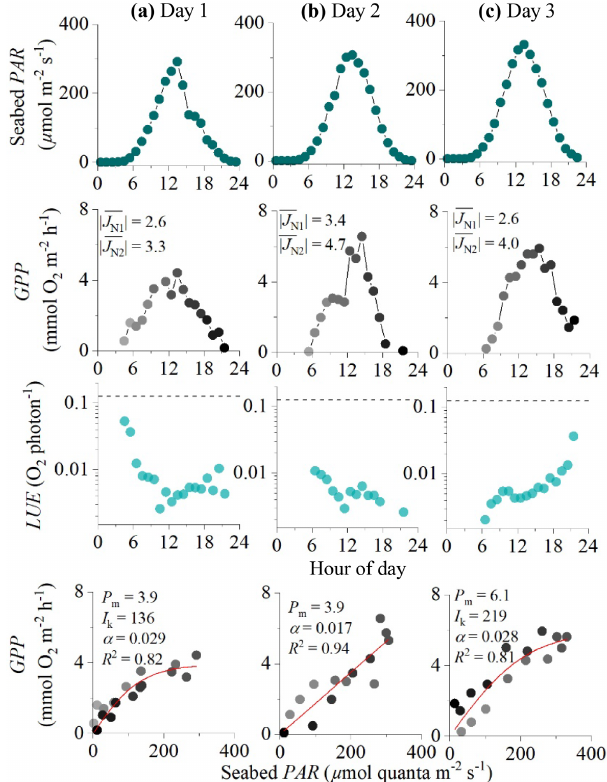
Figure 5. Eddy covariance data measured over 3 consecutive days in the rocky mussel reef in the Baltic Sea showing seabed PAR (top panels), hourly GPP (second row), estimated hourly LUE (third row; dashed lines indicate theoretical limit), and corresponding light saturation curves (bottom panels). Symbols in the middle and bot- tom panels are colour-mapped by hour of day. Light saturation curves are fitted to the data showing the maximum rate of GPP ( P m , mmol O 2 m − 2 h − 1 ), the photoadaptation parameter I k (µmol PARm − 2 s − 1 ), the initial slope of the curve α , and the coefficient of determination ( R 2 ). For each 24h period, average fluxes for the first and second night-time periods are shown in the middle panels ( | J N1 | and | J N2 | , mmol O 2 m − 2 h − 1 ). Data modified from Attard et al. (2020).